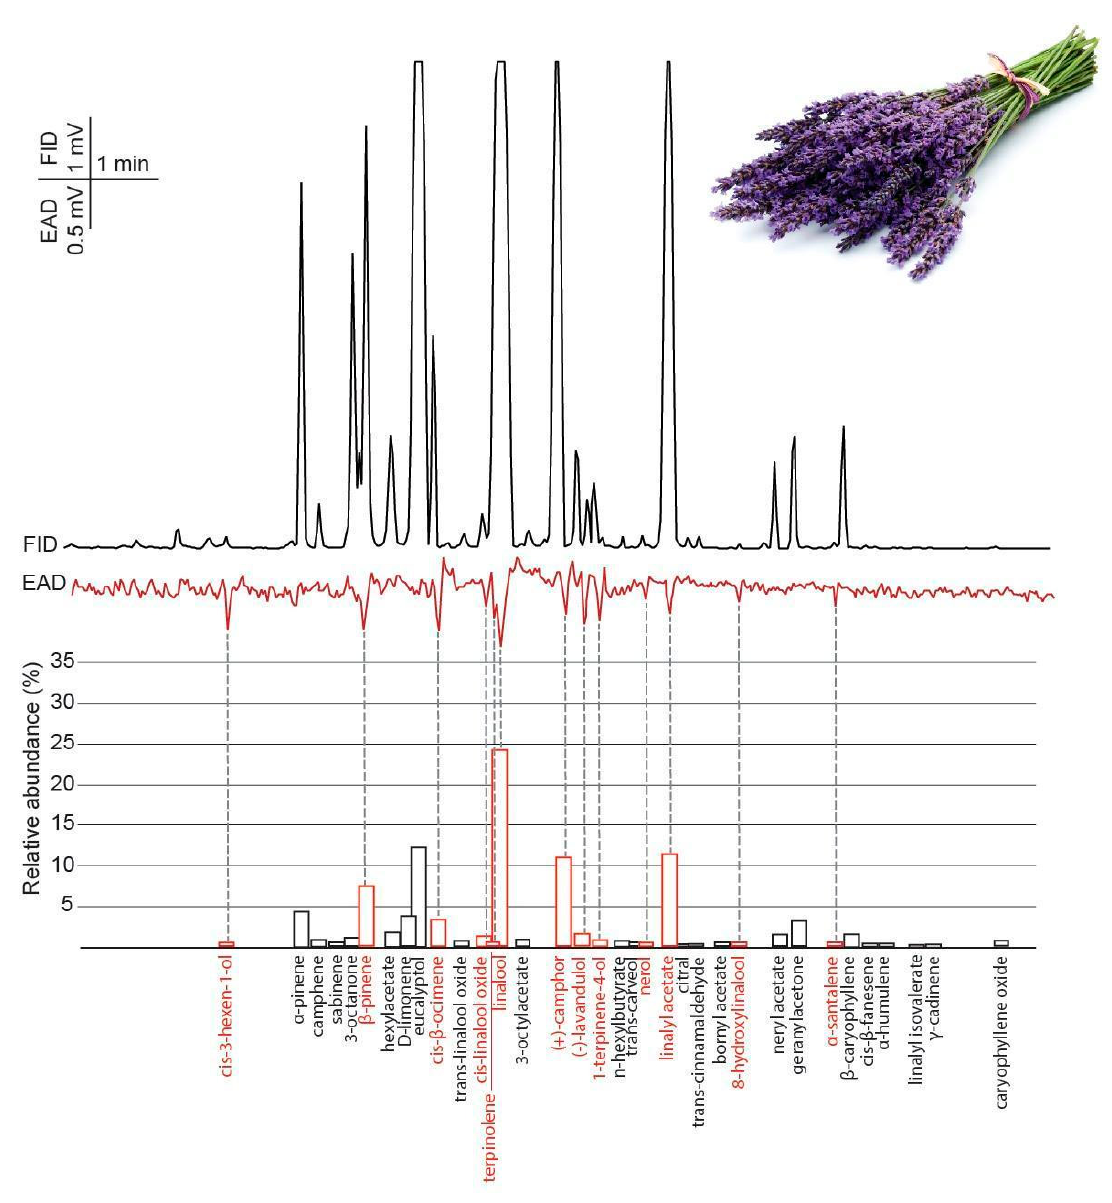
Figure 5. The averaged antennal response (EAD) of female box tree moths ( Cydalima perspectalis ) to lavender essential oil headspace samples (collected with SPME) measured by gas chromatography coupled electroantennographic detection (GC-EAD) (n = 5). Bars indicate the relative abundance of volatile constituents based on GC-MS analysis. The names of antennal active volatiles are highlighted in red.